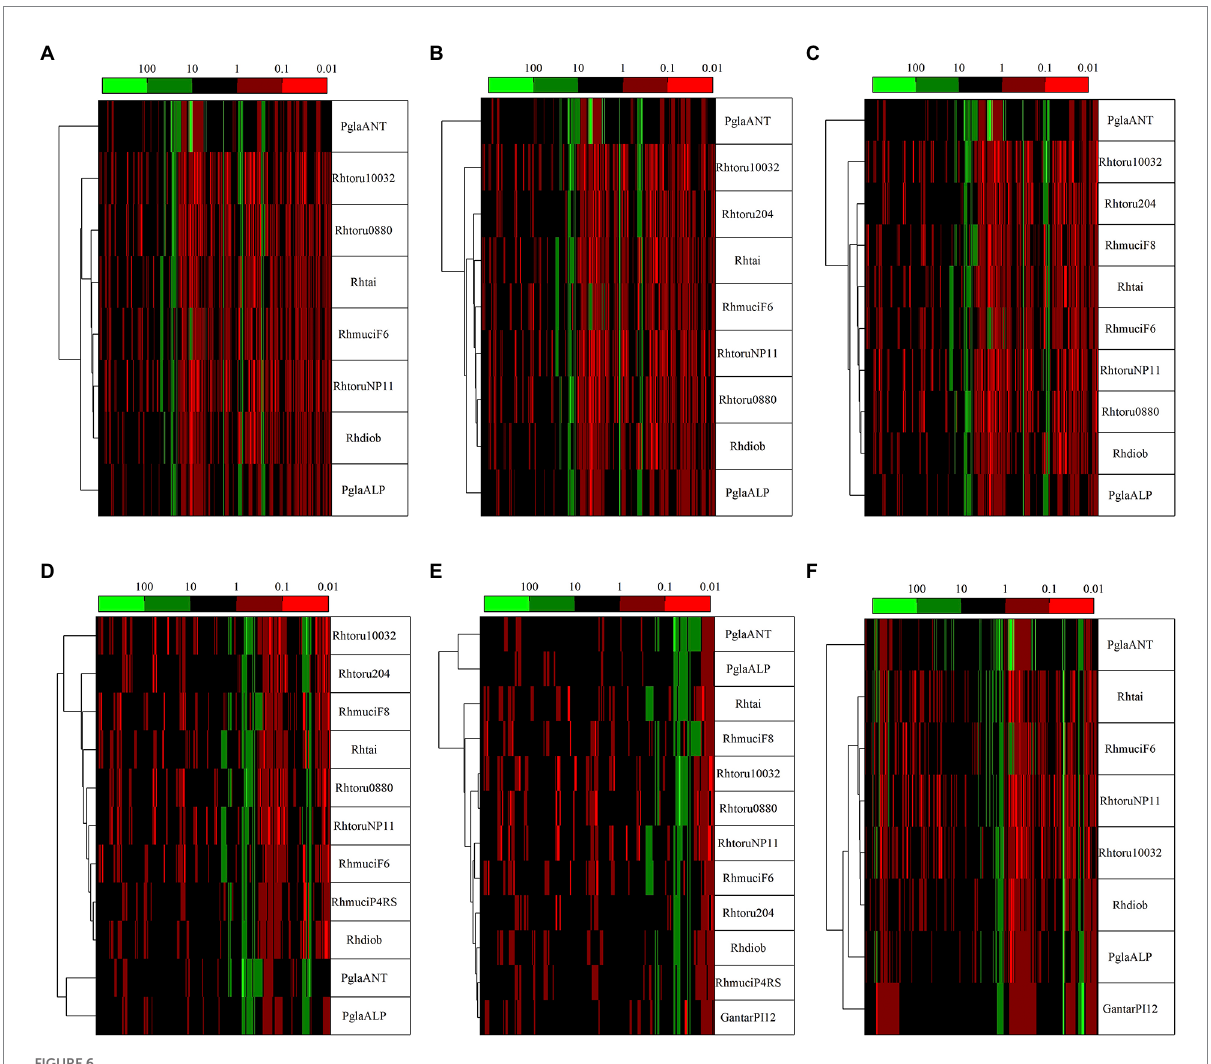
FIGURE 6 Comparison among yeasts based in phylogenetic analysis of individual proteins. Comparisons were made based on the patristic distances extracted from threes computed for proteins (Supplementary Figure S3) that were common to at least 8 yeasts, including both P. glacialis isolates. (A) , 50 proteins common to 8 yeasts; (B) , 41 proteins common to 9 yeasts; (C) , 35 proteins common to 10 yeasts; (D) , 23 proteins common to 11 yeasts; (E) , 24 proteins common to 12 yeasts. In (F) , was considered the proteins common at least for P. glacialis and G. antarctica (31 proteins common to 8 yeasts). PglaALP, P. glacialis isolate from Italian Alps; PglaANT, P. glacialis isolate from Antarctica; GantarPI12, Glaciozyma antarctica PI12; Rhdiob, Rhodotorula diobovata strain UCD-FST 08–225; RhmuciF6, Rhodotorula mucilaginosa strain F6; Rhmuci, Rhodotorula mucilaginosa strain F8; Rhhai, Rhodotorula taiwanensis strain MD1149; Rhtoru204, Rhodotorula toruloides ATCC 204091; RhtoruNP11C, Rhodotorula toruloides strain NP11C; Rhtoru10031, Rhodotorula toruloides strain NBRC10032; Rthoru0880, Rhodotorula toruloides strain NBRC